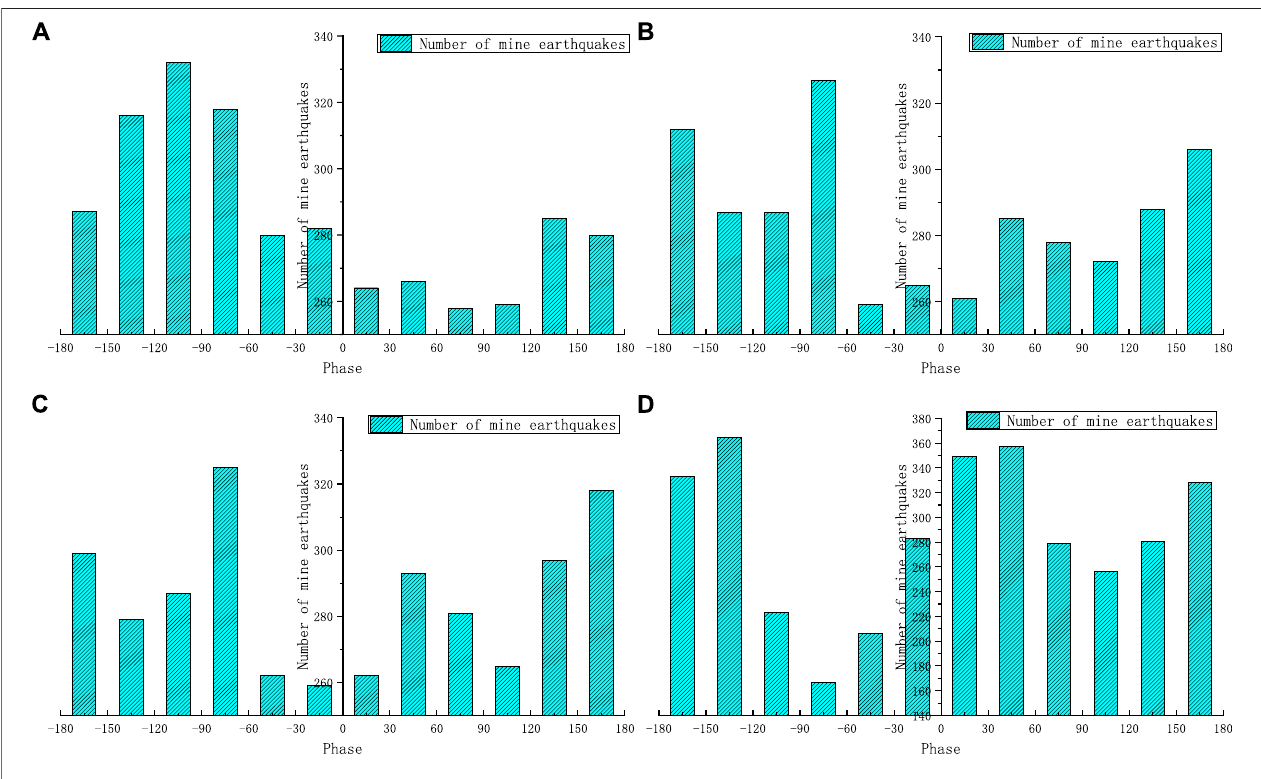
FIGURE 3 | Statistical histogram of the mine earthquake